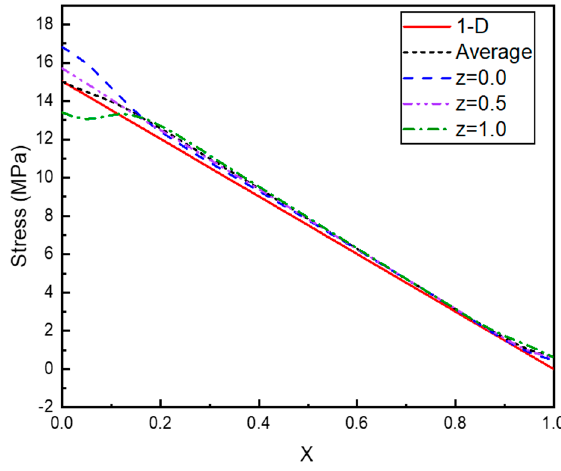
Figure 4. Distributions of stress along the x axis at the upper surface of the sensing element for δ = 7.5 μ m.